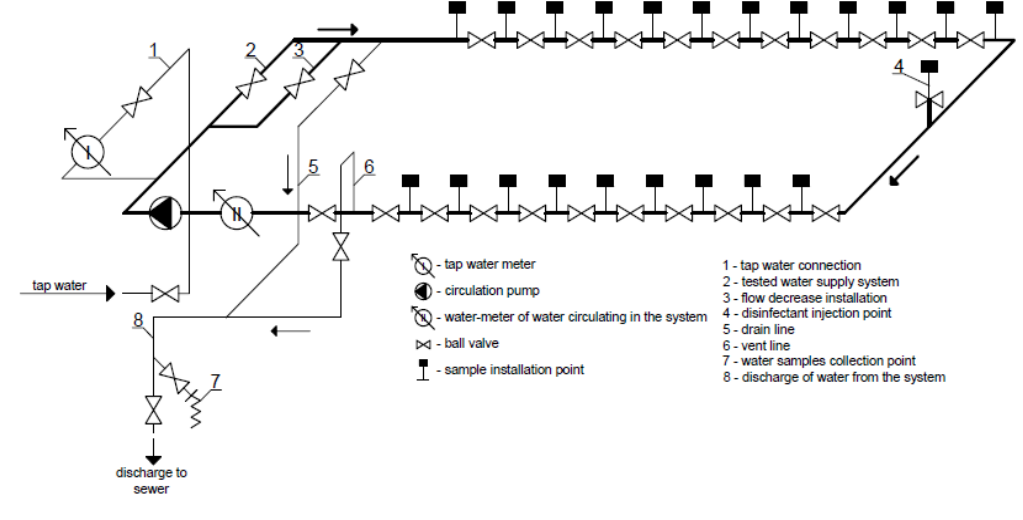
Figure 1. The scheme of the experimental installation.